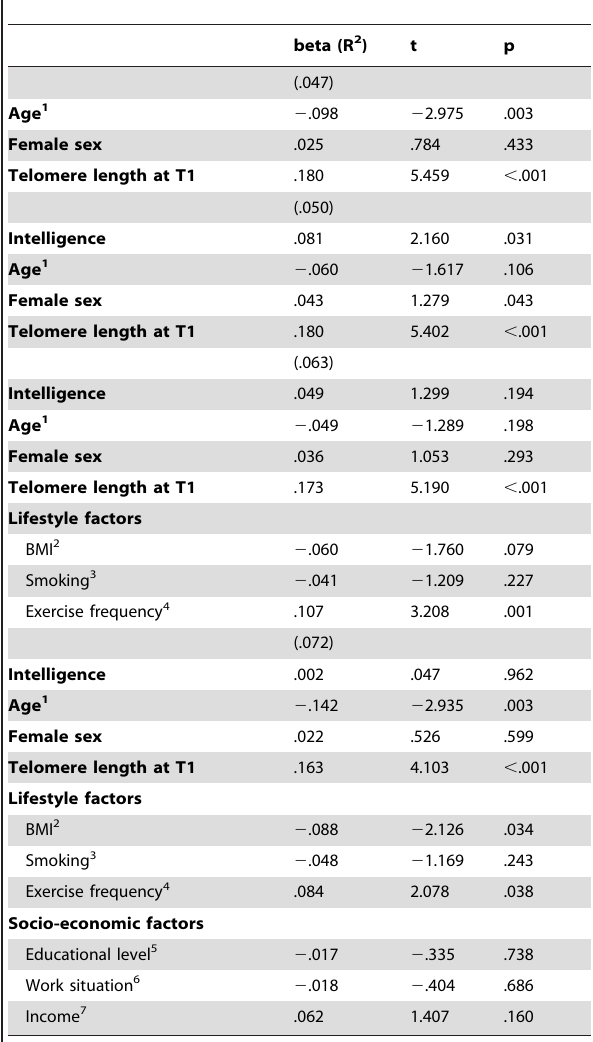
Table 3. Multivariable associations between intelligence and telomere length at